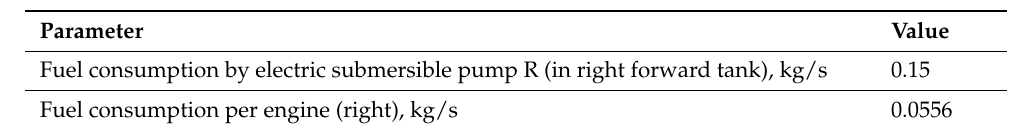
Table 1. Simulation